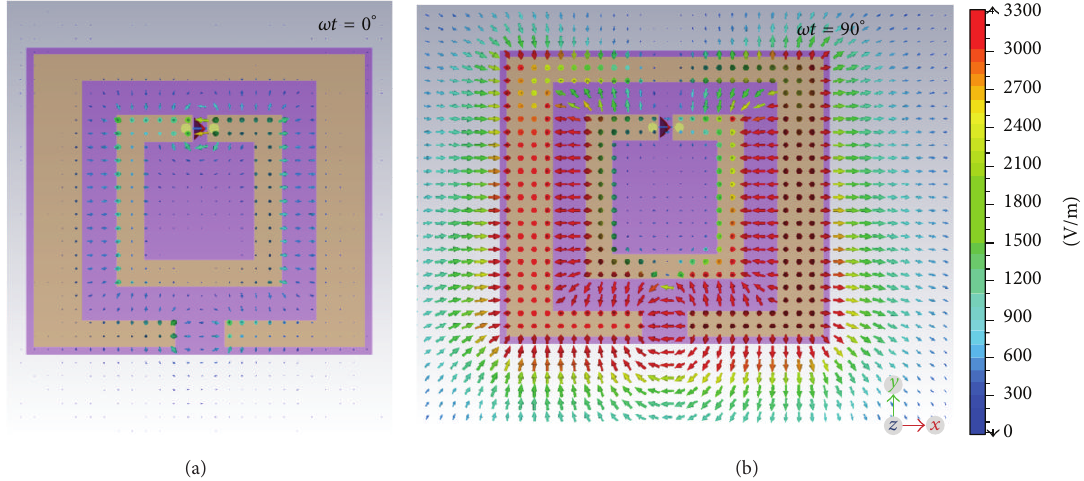
Figure 7: Electric field distributions of the antenna without ground plane in the 𝑥 - 𝑦 plane on the element surface at 920 MHz with (a) 𝜔𝑡 = 0 ∘